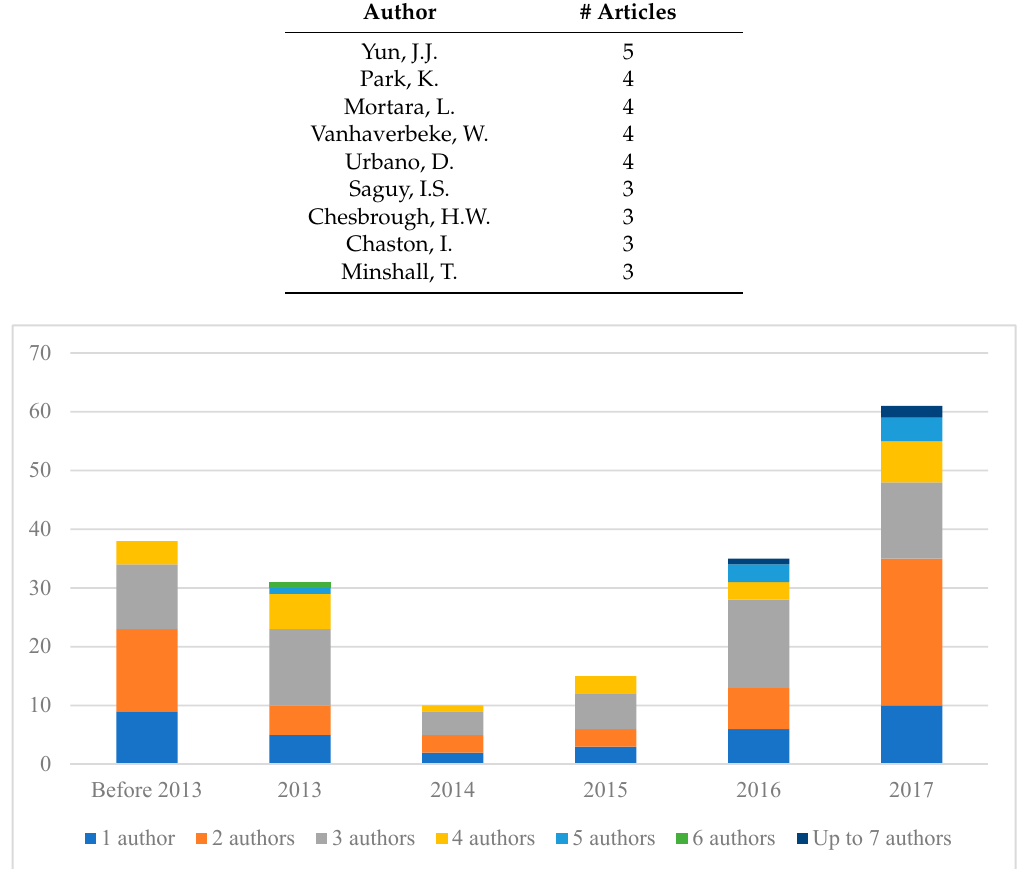
Figure 3. Number of authors per publication.